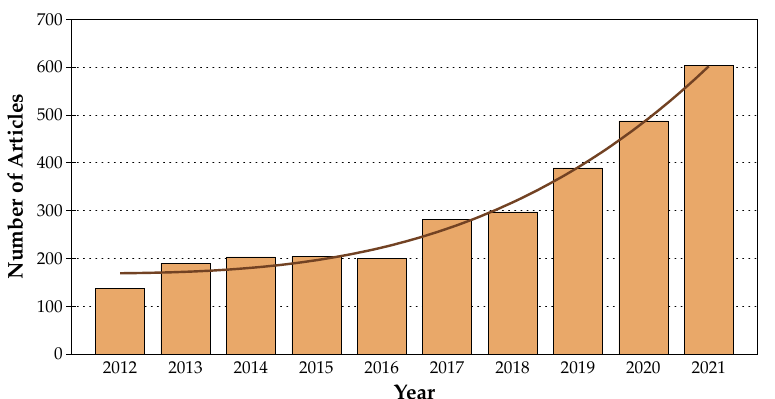
Figure 1. Number of research articles published in Scopus-index sources from 2012 to 2021.